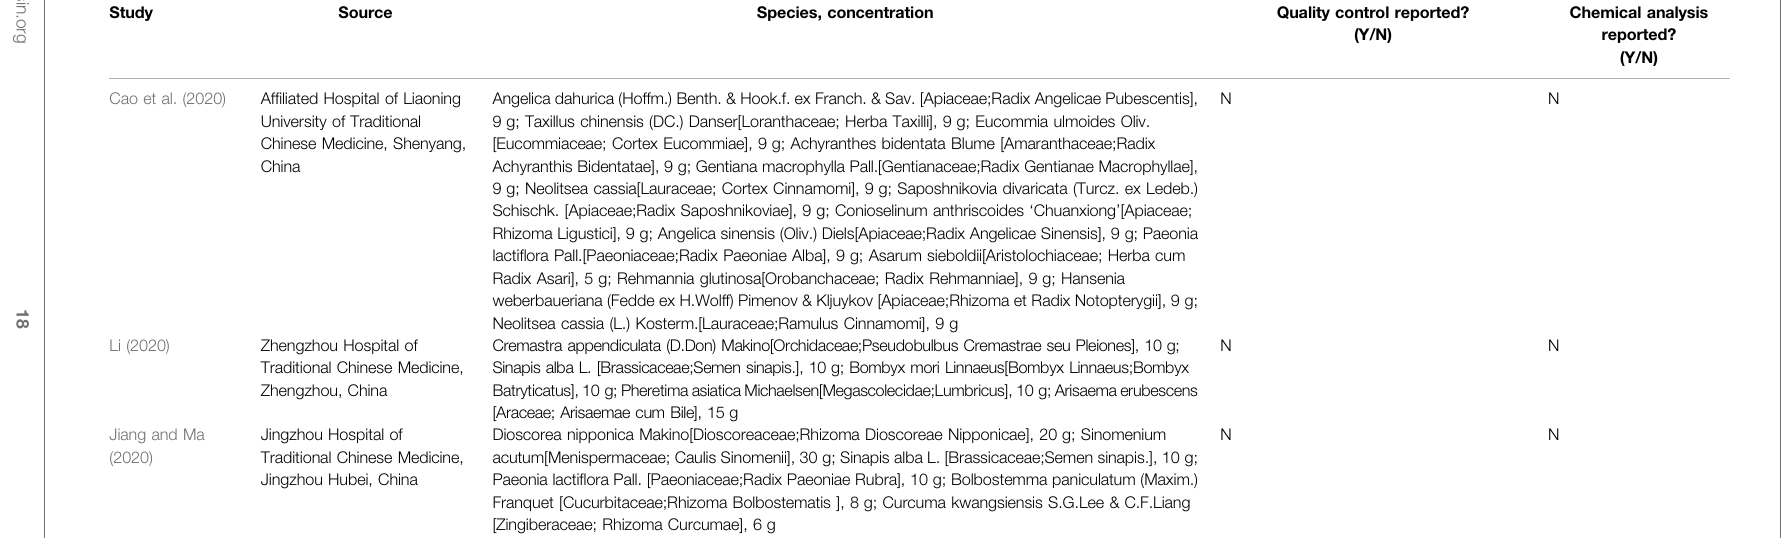
TABLE 2 | ( Continued ) A summary table describing the composition of the